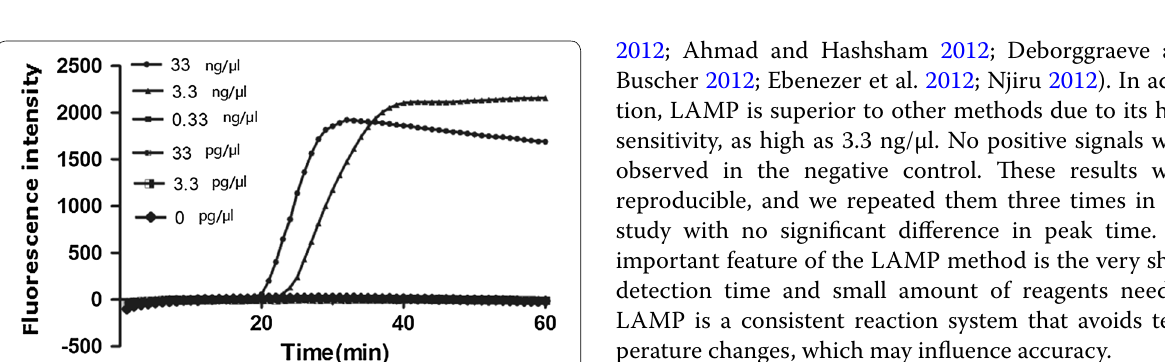
Fig. 5 Sensitivity of LAMP for the amplification of Zika